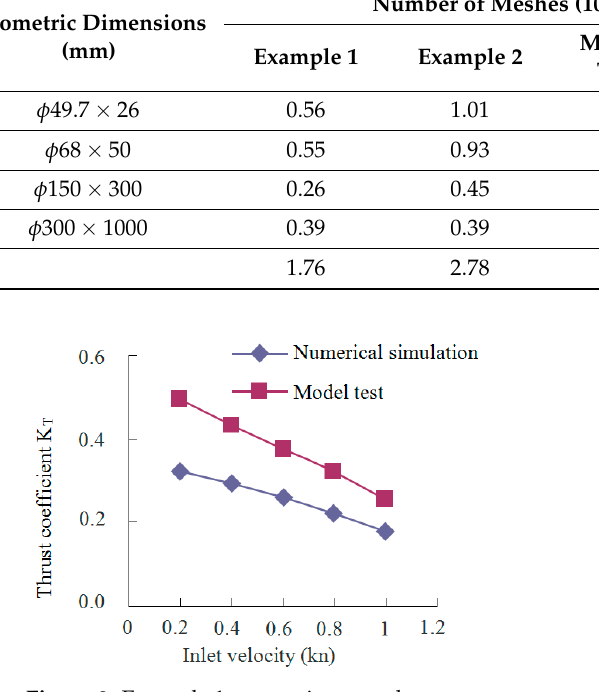
Figure 2. Example 1 comparison results.